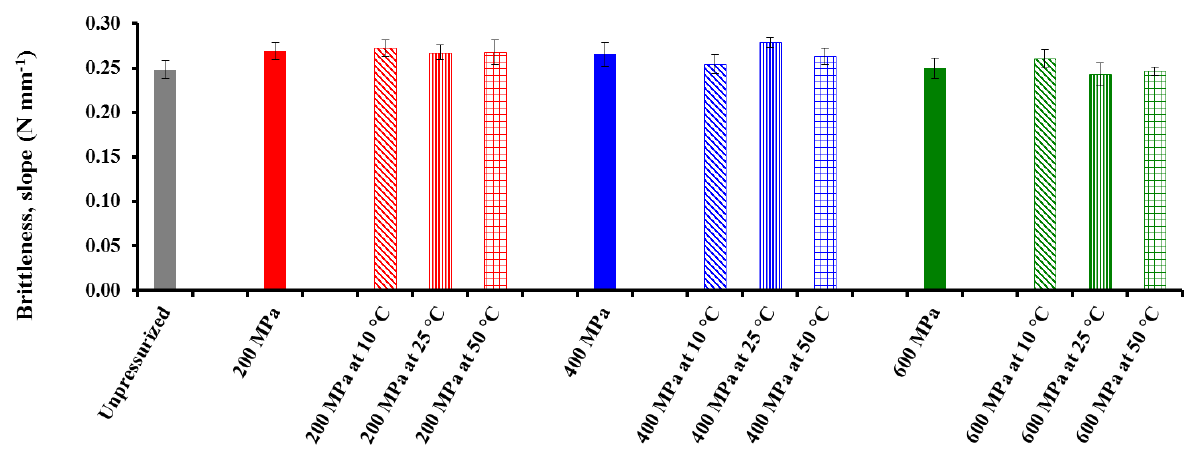
Figure 5. Effect of pressure and treatment temperature on the brittleness (slope) of chickpea gel heat-induced from pressurized powder at 25 °C. Mean values of 10